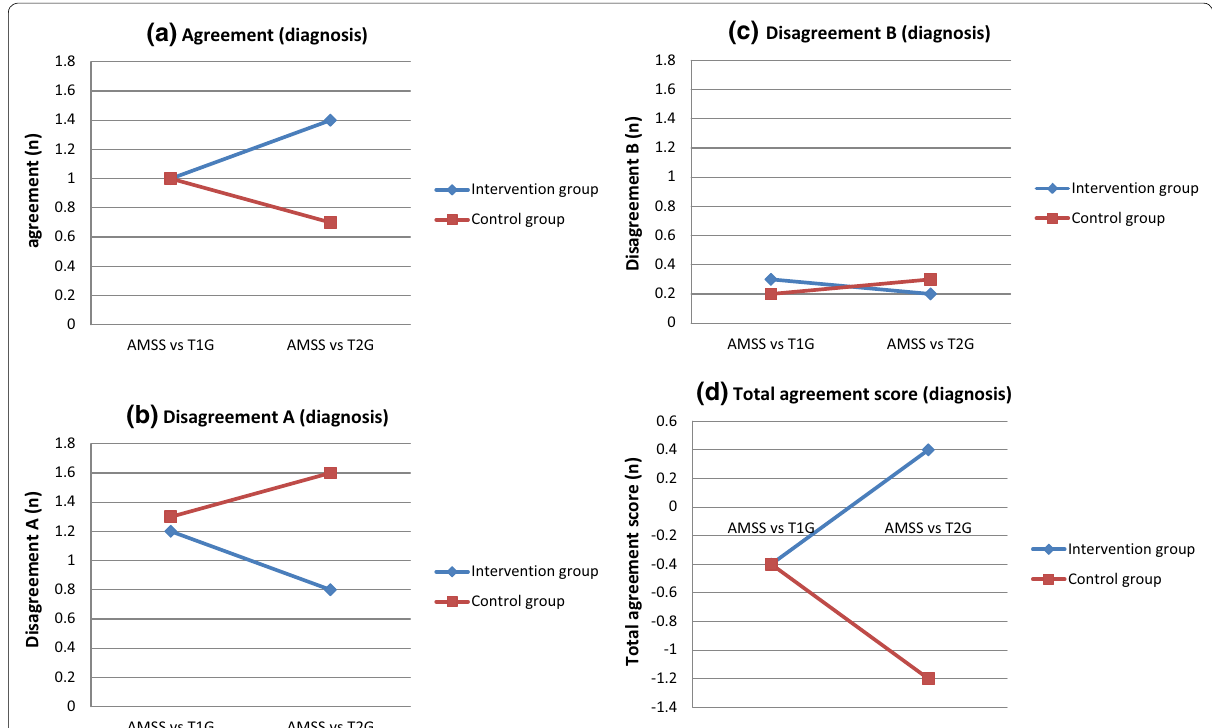
Fig. 3 Agreement concerning diagnosis by AMSS and diagnosis reported by GPs (T1 and T2). Selection based on complete data sets at T1 and T2 (intervention group n GP